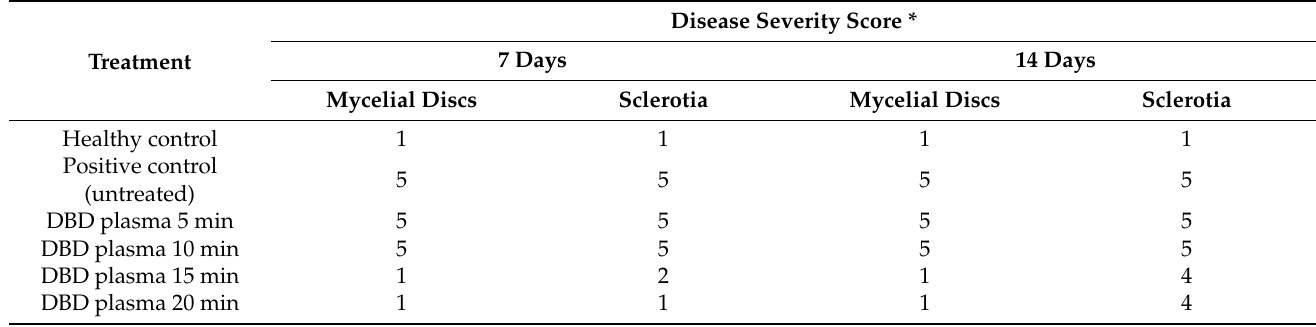
Table 3. Disease severity of southern blight on lettuce caused by Athelia rolfsii after DBD plasma exposure for different